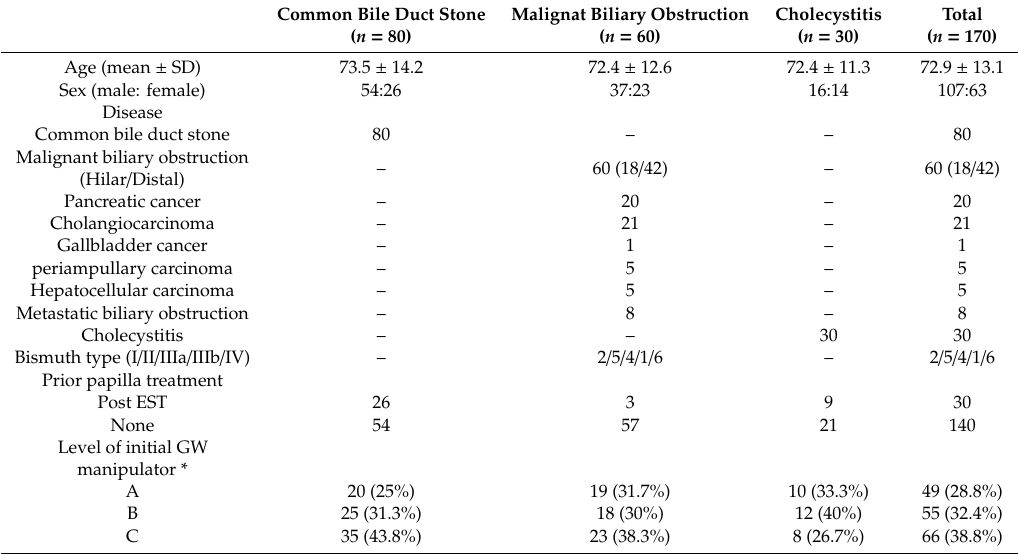
Table 1. Patient